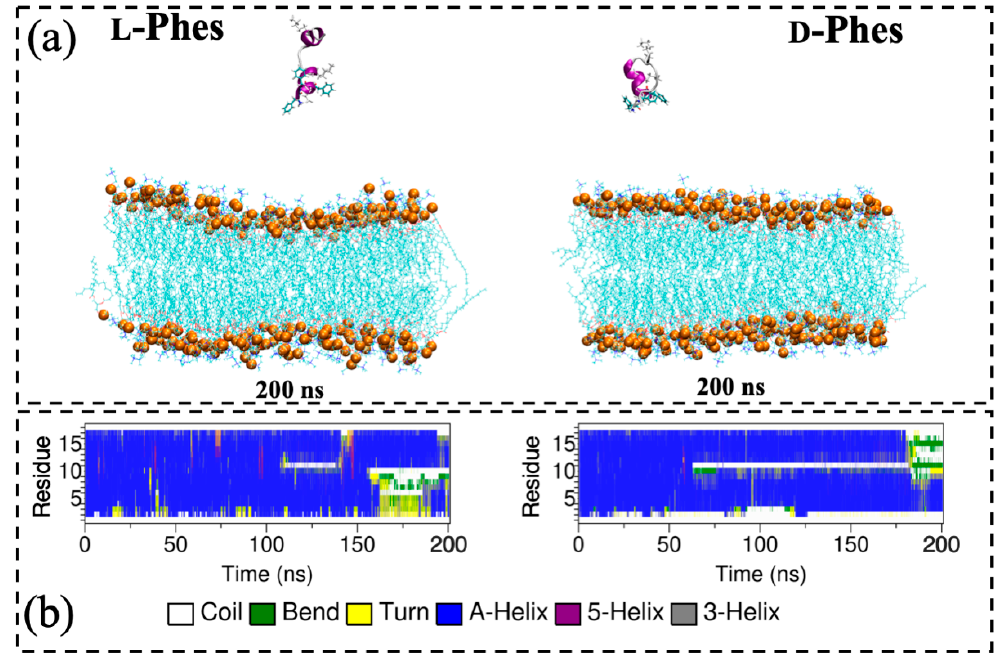
Figure 4. The last snapshots of the second type of simulations of L- (left) and D-Phes (right) ( a ) and corresponding secondary structure profiles during the simulations ( b ). Water molecules and ions were omitted for the clarity. Charged and three phenylalanine residues are shown by licorice model. Orange balls show phosphorus atoms of DMPC membrane.